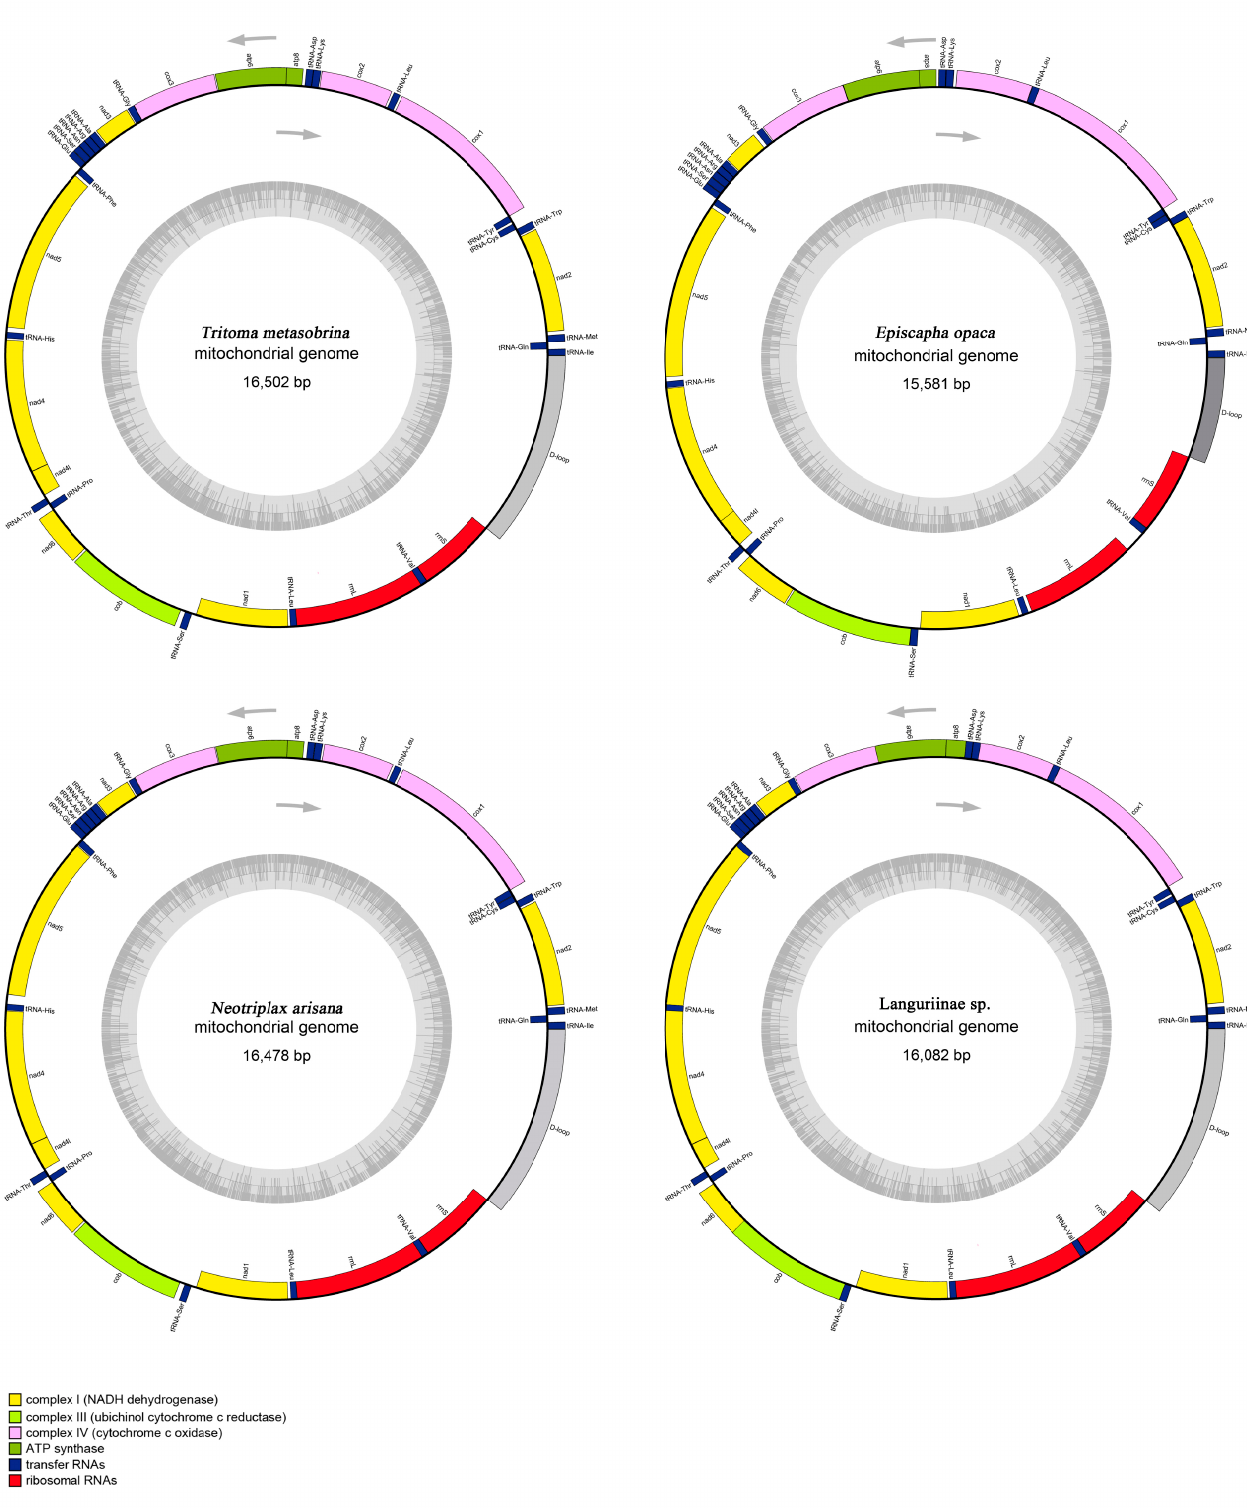
Figure 1. Mitochondrial map of T. metasobrina , E. opaca , N. Arisana, and Languriinae sp. The tRNAs, rRNAs, and PCGs are denoted by the color blocks. Genes outside the map are transcribed clockwise, whereas those inside are transcribed